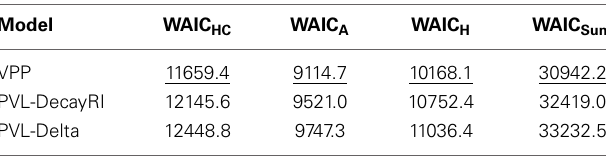
Table 3 | WAIC scores of each model, computed separately for each